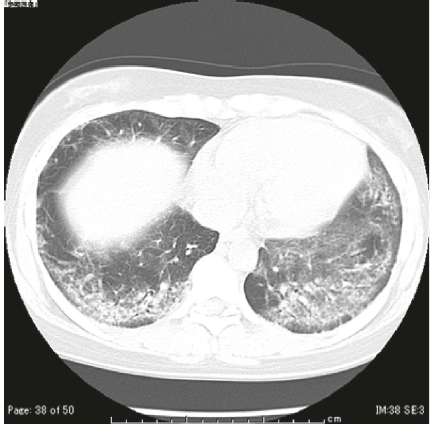
Figure 2: Chest-computed tomography on admission showing ground-glass opacity with partial honeycomb lung throughout the entire lung